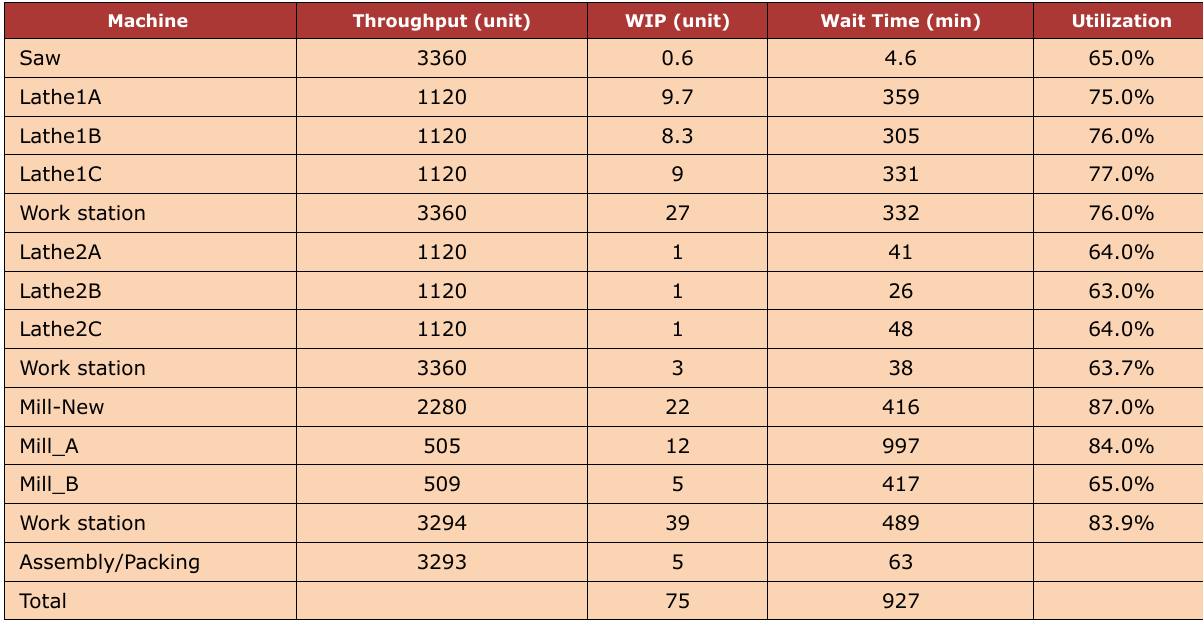
Table A2. Machine performance of three lathes three mills scenario